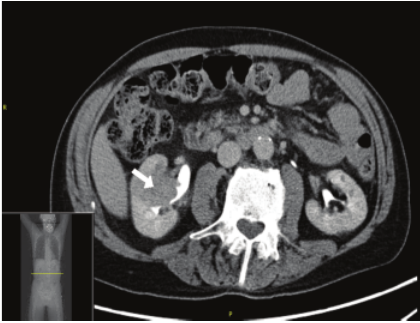
Figure 3: Invasion of leiomyosarcoma into the renal cortex, H&E